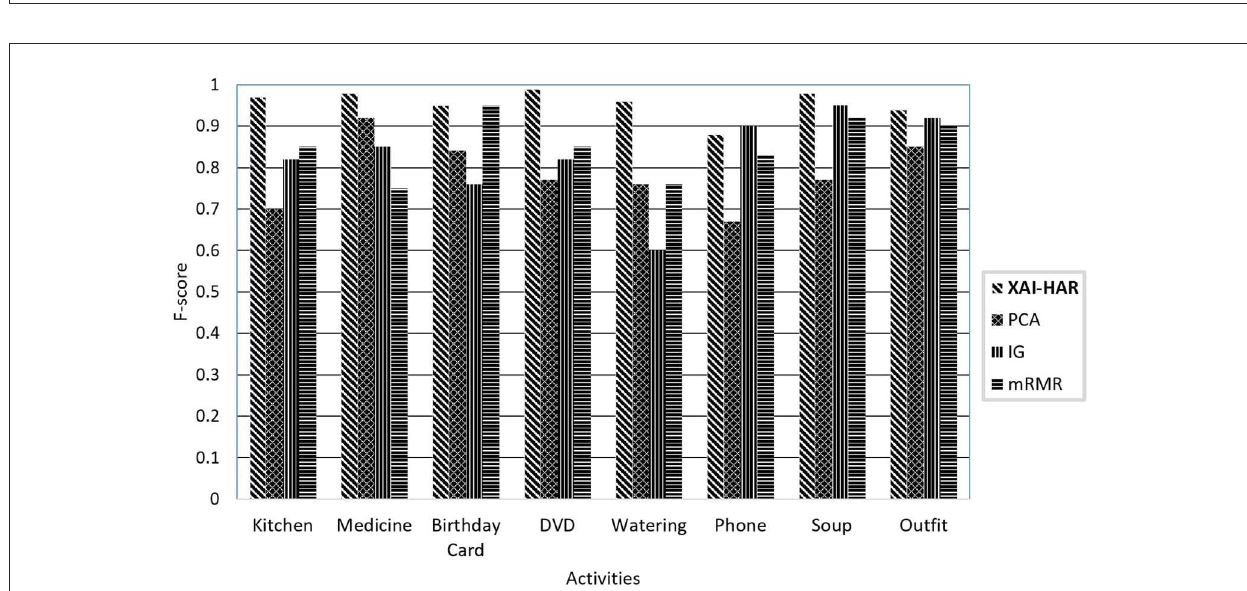
FIGURE4 The comparison of the proposed XAI-HAR with feature selection methods such as PCA, mRMR, and IG in combination with RF for each activity of healthy individuals.